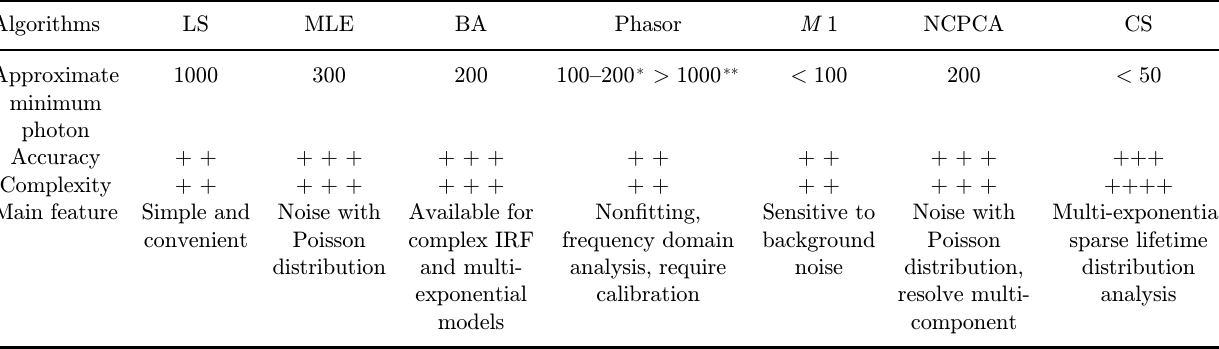
Table 2. Summary of the performance of di®erent algorithms with low photon number. 156 –